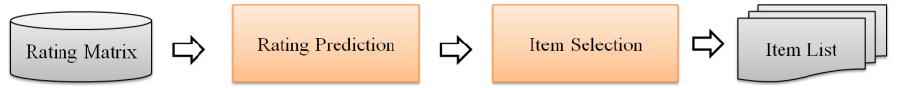
Fig. 1. Work°ow of traditional collaborative